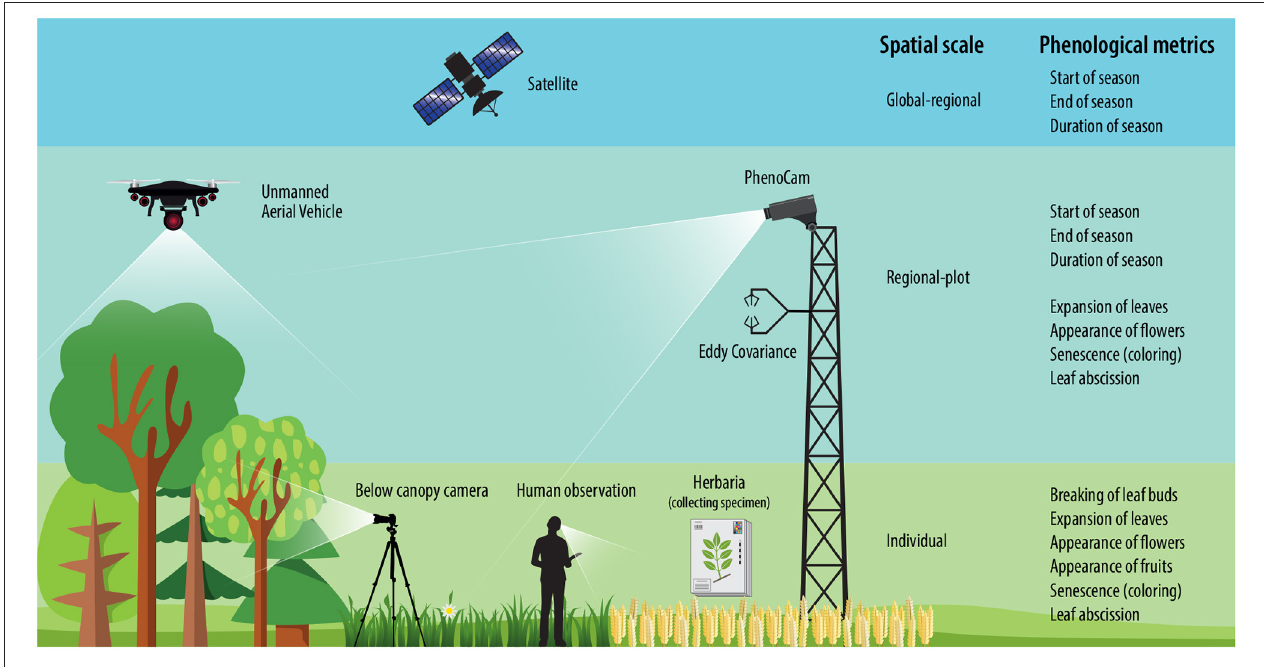
FIGURE 1 | Overview of methods monitoring